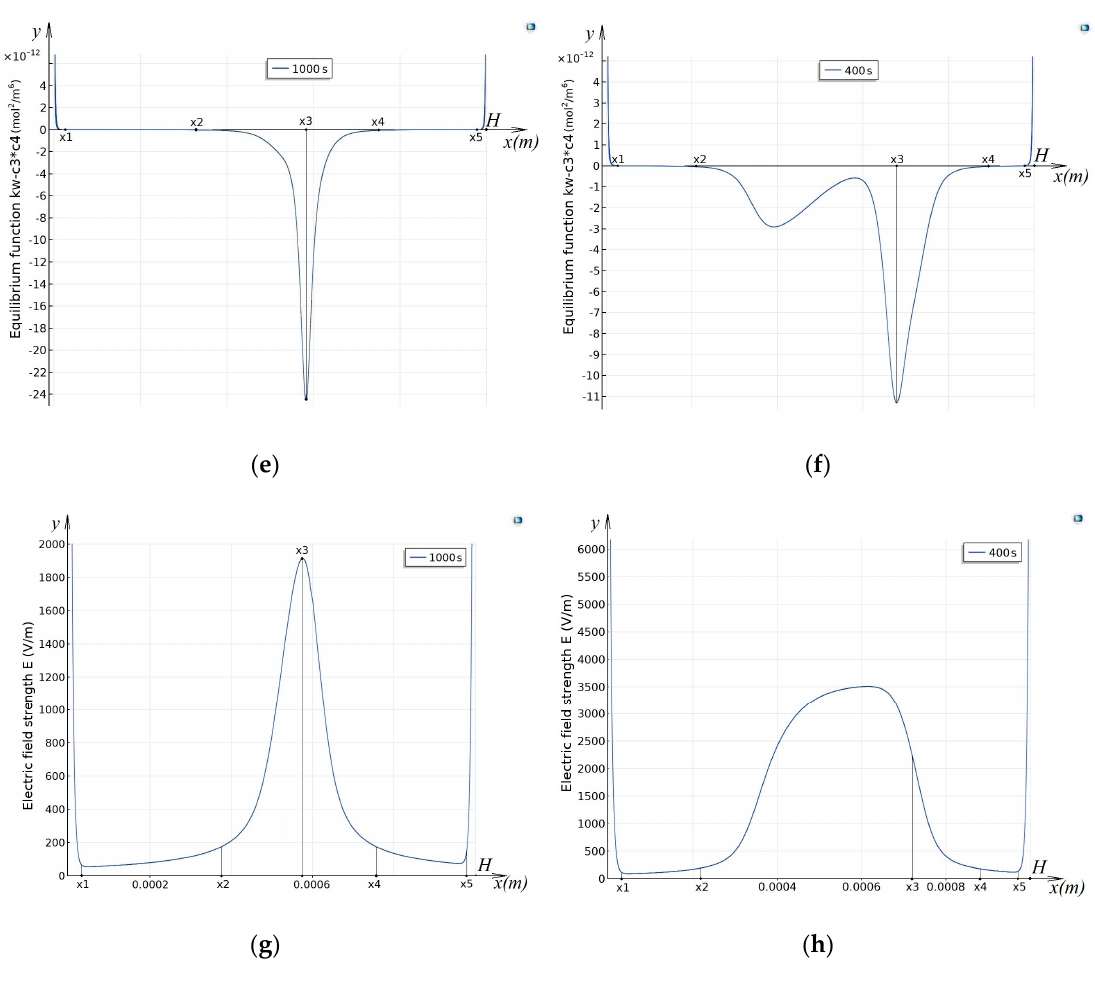
Figure 3. Graphs of concentration functions ( a , b ), charge distribution density ( c , d ), equilibrium ( e , f ), electric field strength ( g , h ). The left column corresponds to ∆ r φ = 0.5 V, and the right— ∆ r φ = 1.5 V. Points, x 1 , ... , x 5 define the boundaries of regions (see in Sections